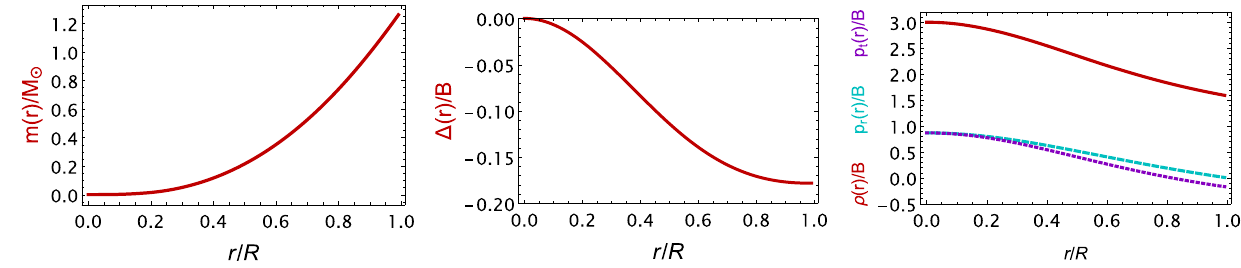
Fig. 1 Anisotropic DE stars within complexity factor: mass function in solar masses (left panel), anisotropic factor (middle panel), and energy density and pressures (right panel) versus radial coordinate throughout the star